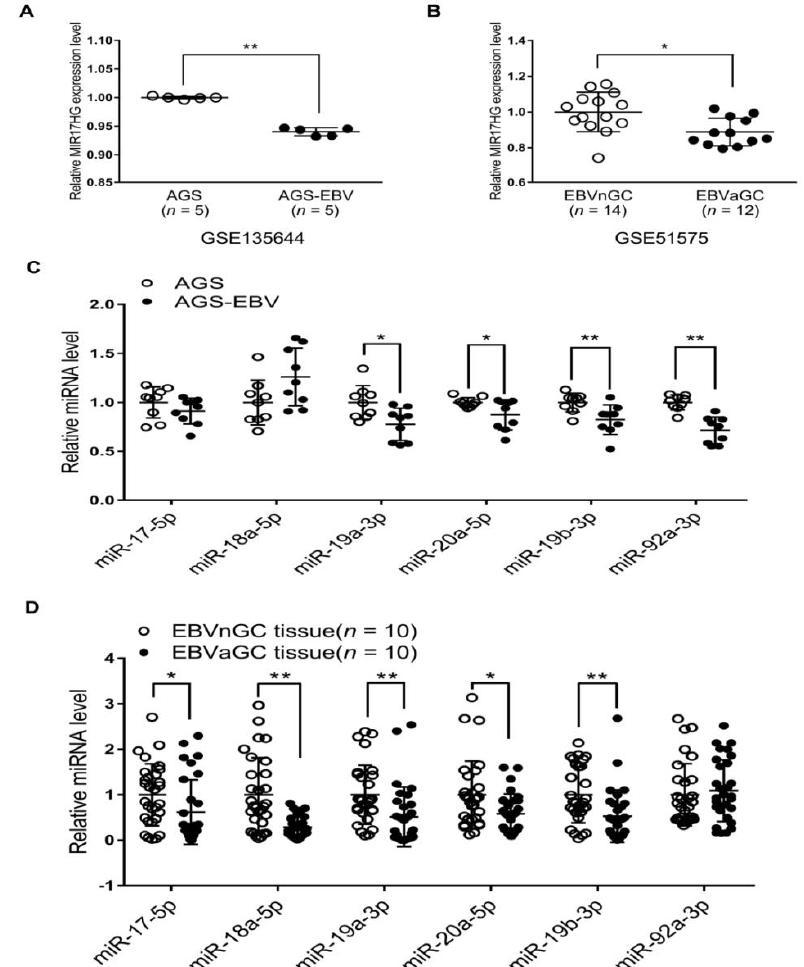
Figure 5. MIR17HG and miR-17-92 cluster miRNA expression in EBV-negative and EBV-positive samples. ( A ) Microarray analysis of MIR17HG expression level in AGS and AGS-EBV cells ( n = 5). ( B ) Results of the GEO database analysis for MIR17HG expression in EBVnGC and EBVaGC cases. ( C ) and ( D ) The qRT-PCR analysis of miR-17-92 cluster miRNA expression was carried out using a SYBR Green qPCR kit. ( C ) Total RNA was extracted from AGS and AGS-EBV cells. Three sets of independent experiments were performed. ( D ) Total RNA was extracted from EBVaGC ( n = 10) and EBVnGC ( n = 10) samples, and qRT-PCR analyses were performed. The data were analyzed using Student’s t -test. Error bars indicate the SD. *, p < 0.05; **, p < 0.01.